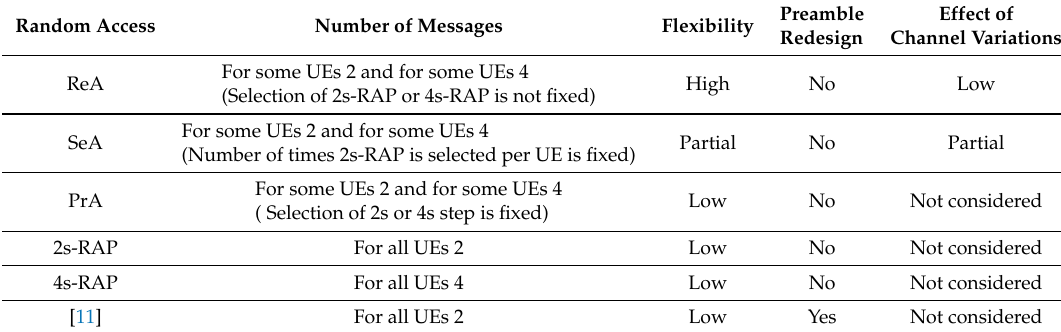
Table 1. Table of comparison.